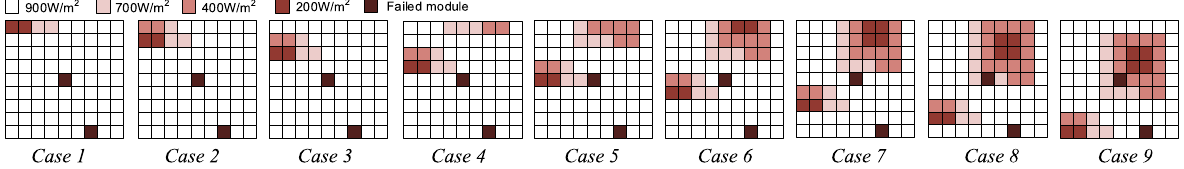
Fig. 8 Shade dispersion of scenario 5 (moving shading with random modules failure)